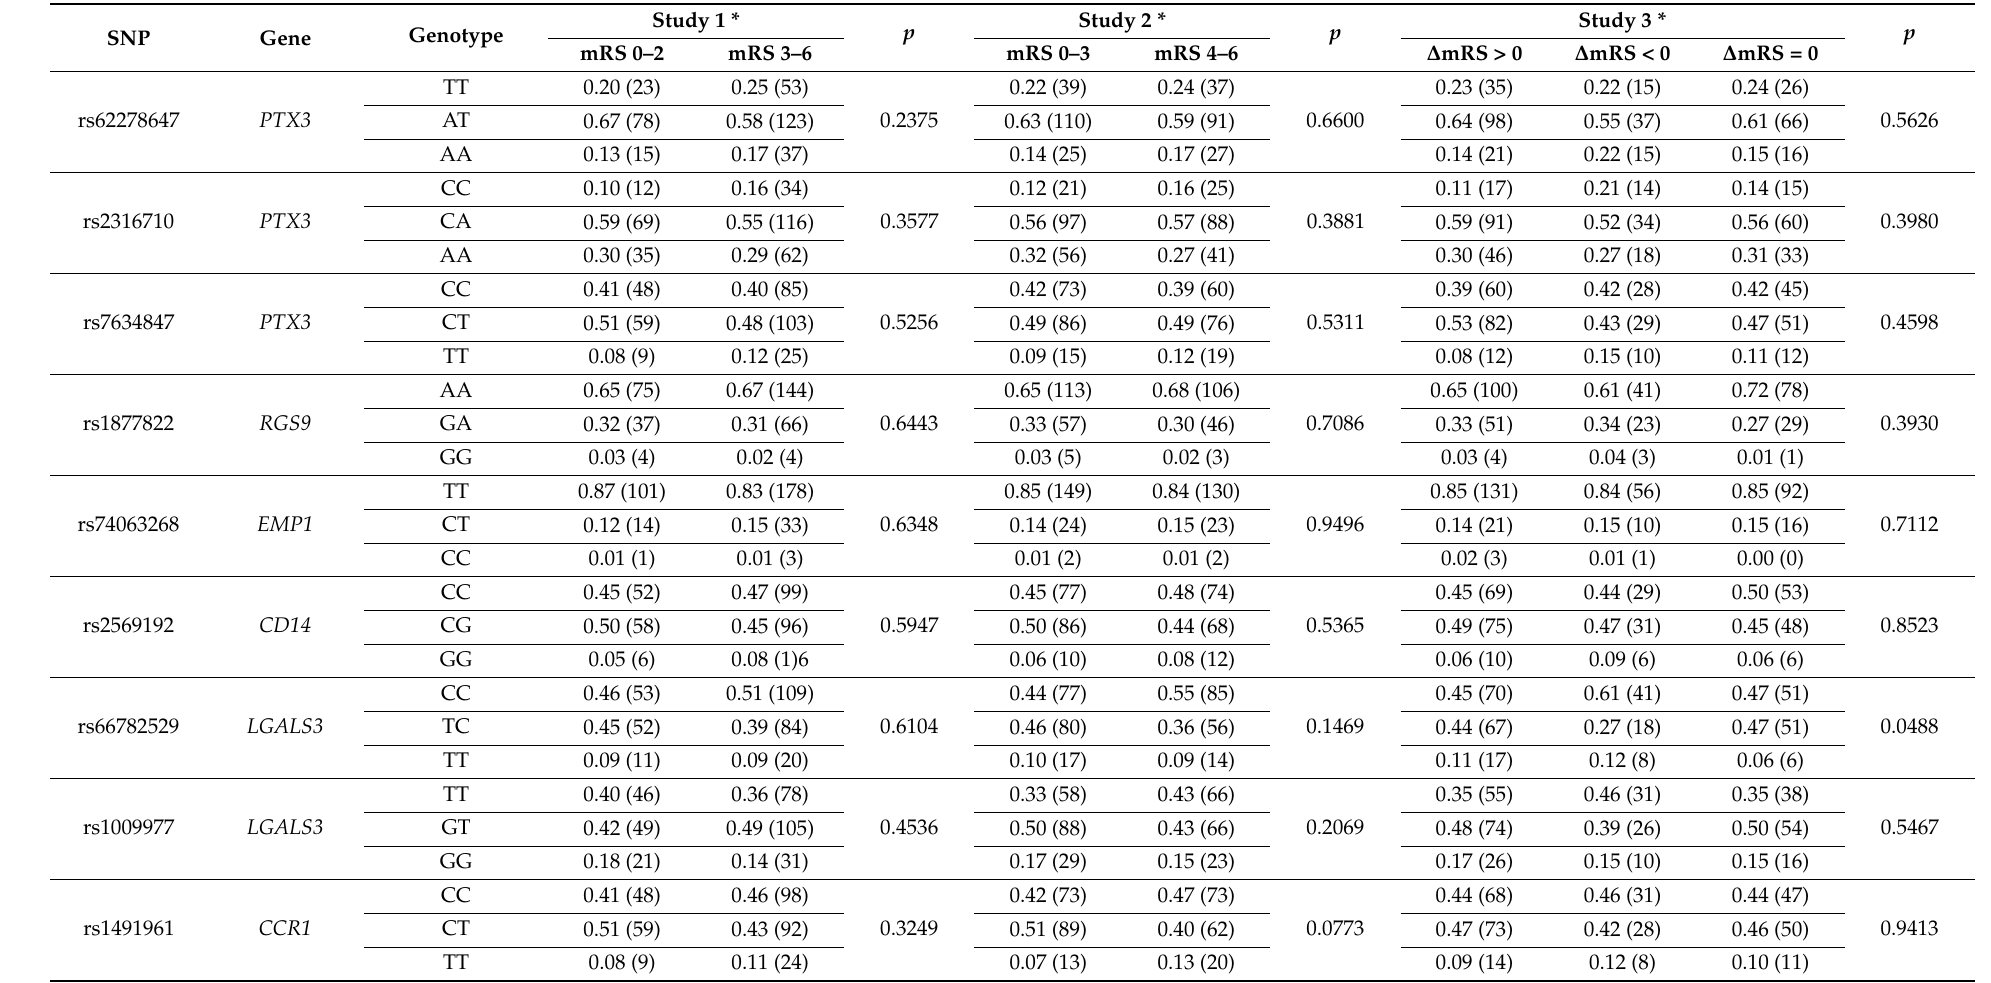
Table 2. Frequency of genotypes in the groups of patients from Studies 1, 2 and